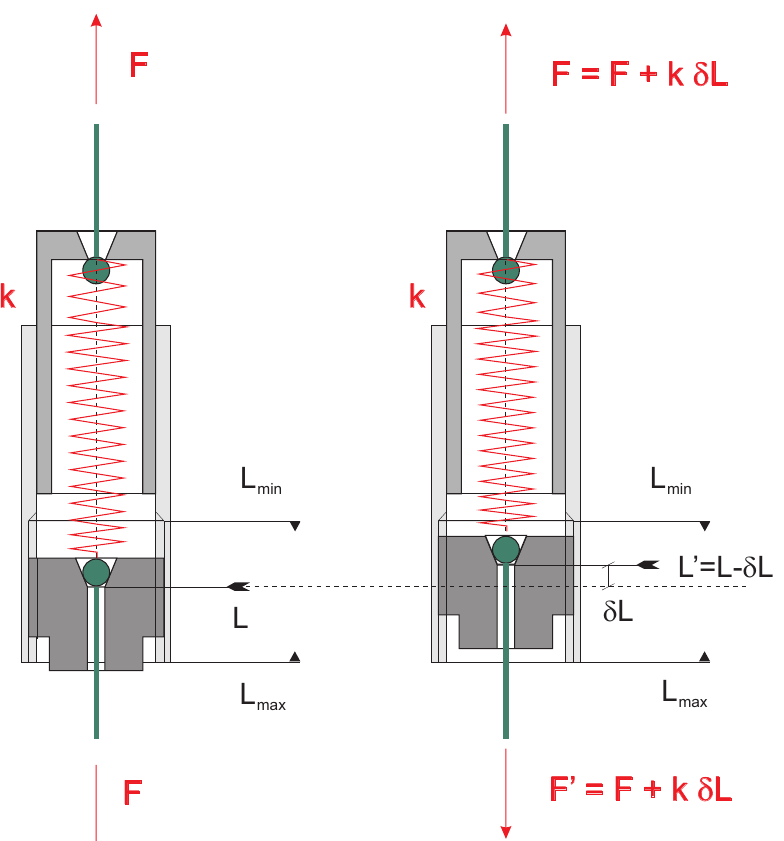
Figure 5. Screw adjustment in the tie system: ( left ) Tie system before adjustment; and ( right ) tie system after the screw